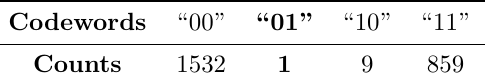
Table 4: O ( ct 1 ) ||O ( ct 2 ) for [ − 3 , 3]